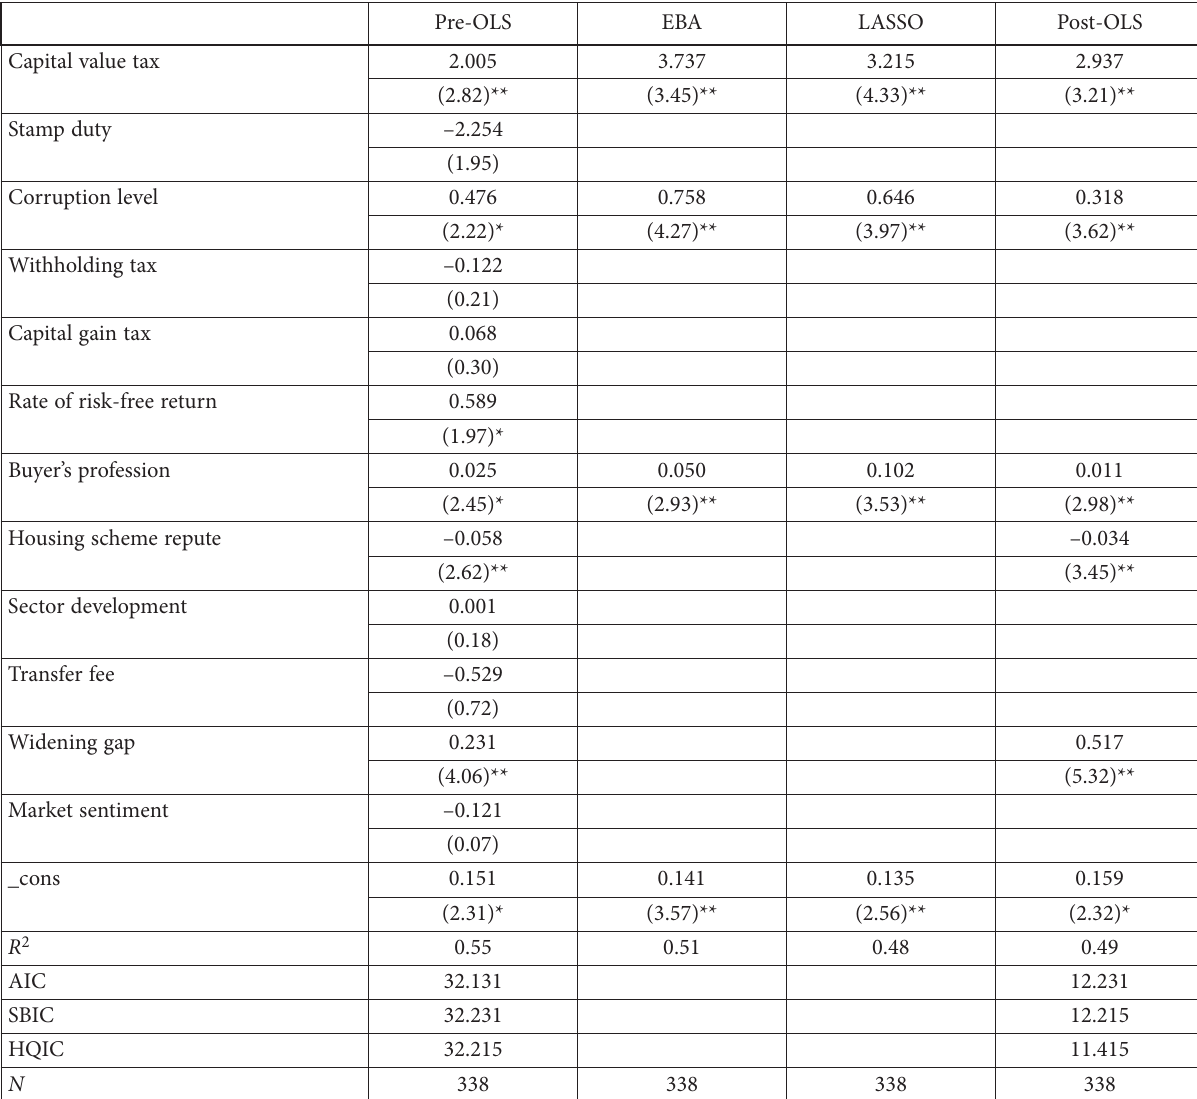
Table 13. Least squares estimates of parameters (source: author’s calculation) Pre-OLS EBA